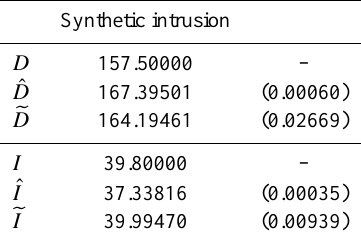
Table 4. Test with synthetic data (Fig. 11) produced by a complex geological scenario. Comparison between the estimated and true values of the magnetization declination D and inclination I . The uncertainties σ D and σ I (shown between parentheses) are calculated by using Eqs. (34) and (35). All values are in degrees ( ◦ ). We use a caret ( ∧ ) and a tilde ( ∼ ) to distinguish the quantities computed by using, respectively, the least-squares ˆ h and robust e h estimates.